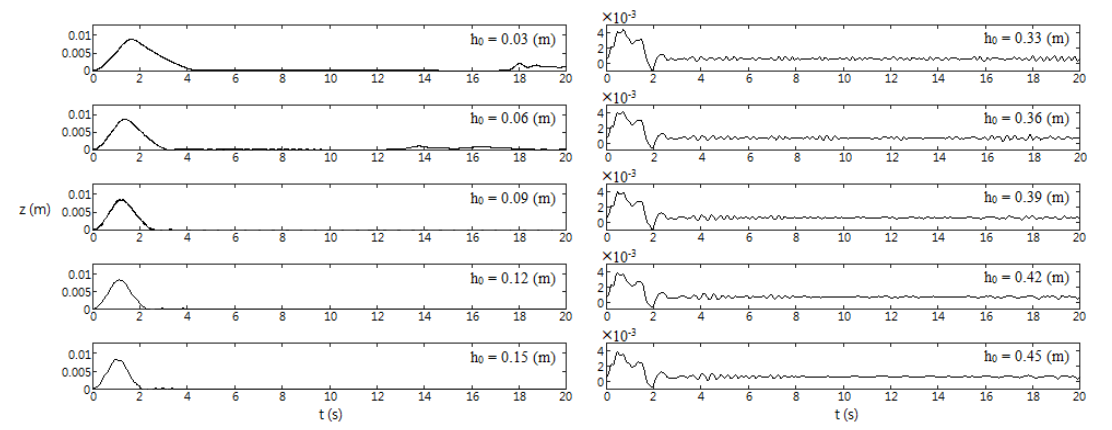
Figure 11. Initial water depth h 0 on wave generation: records of free-surface elevation at the hinge. In all cases, L = 1 m, a = 0.02 m, and b = 0.5 s are used in (1) to describe the bottom motion and a flat beach is consider ( θ = 0). Water depth for each case is indicated in the corresponding